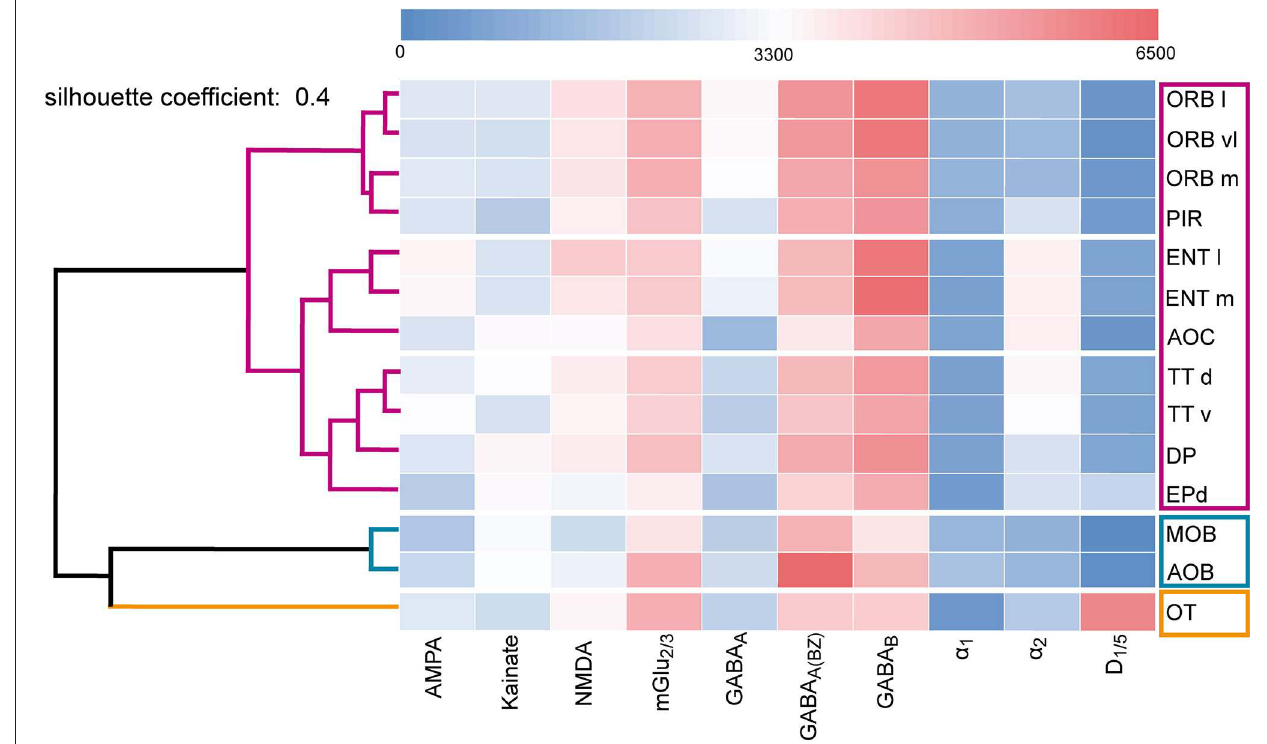
FIGURE 10 | Dendrogram of the hierarchical cluster analysis. The area-specific receptor densities are displayed as a heat map according to their classification into clusters ( Figure 11 ). The color legend represents the receptor densities (fmol/mg protein). Red color indicates high values ( > 3,300 fmol/mg protein), while blue color displays lower values ( < 3,300 fmol/mg protein). For abbreviations see ( Figure 1